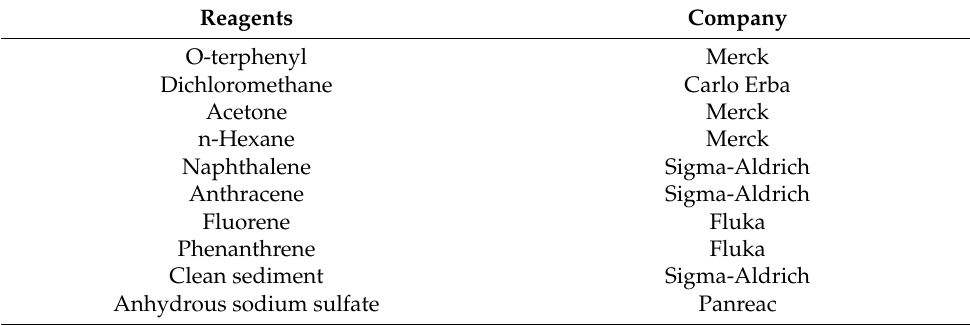
Table 1. Reagents used in the